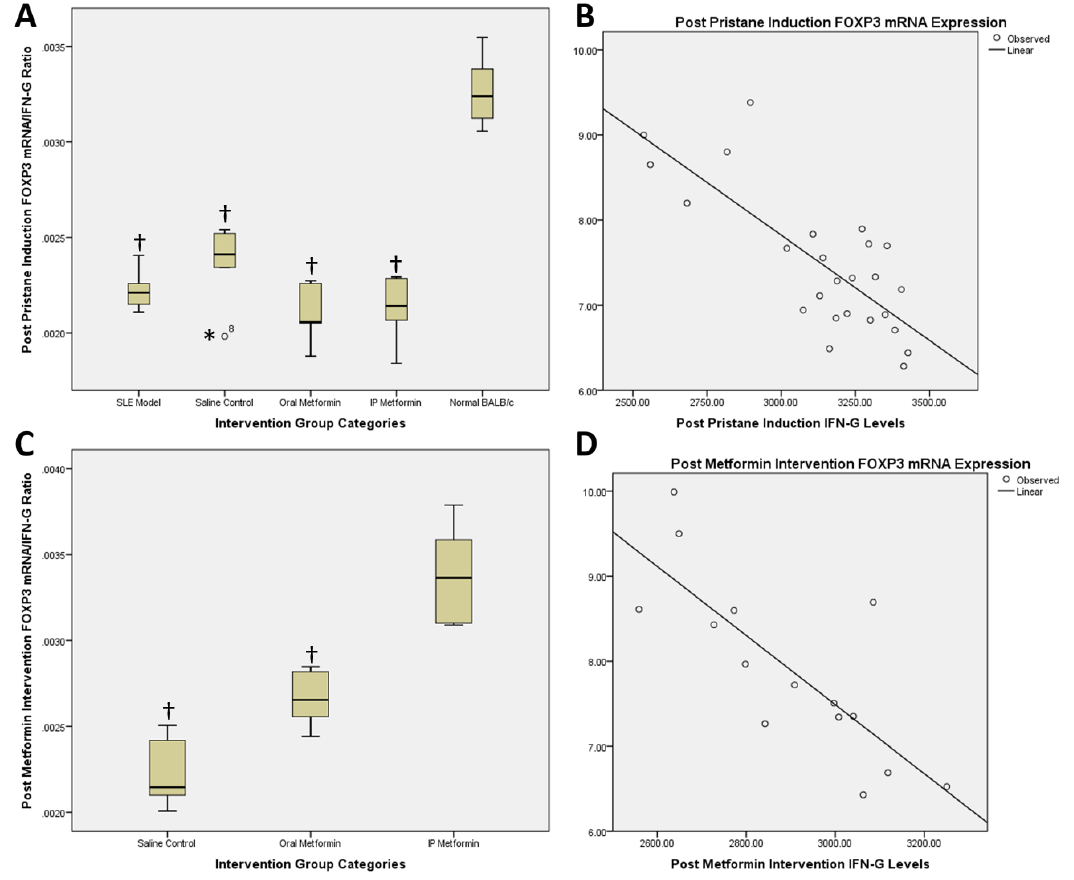
Figure 2. Post pristane induction FOXP3 mRNA/IFN-gamma ratio and correlation scatter plot ( A and B ) and post metformin therapy FOXP3 mRNA/IFN-gamma ratio and correlation scatter plot ( C and D ). †statistically significant compared to control groups;